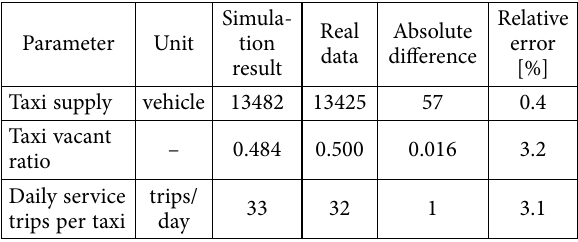
Table 2. SD simulation results compared with actual